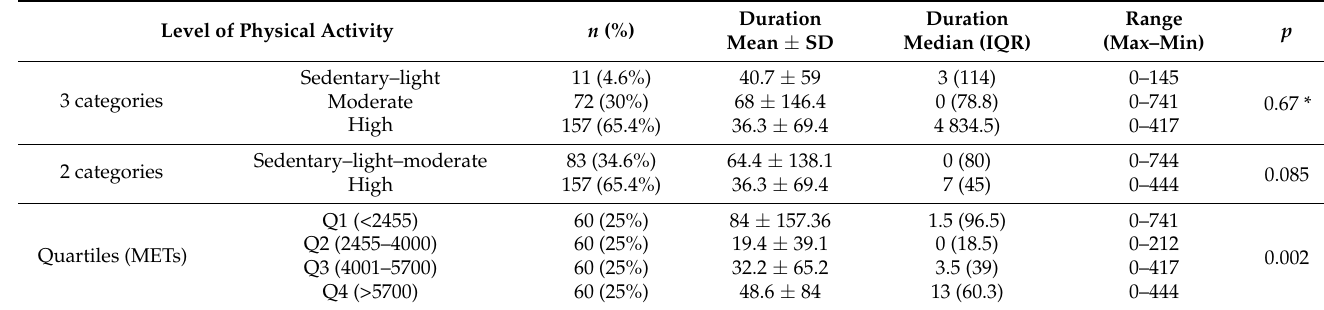
Table 4. Level of physical activity and duration of common illness/workplace injury.